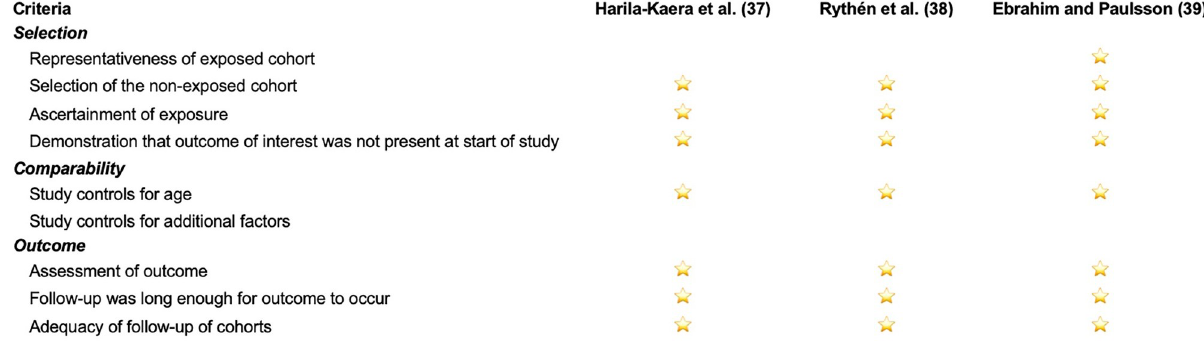
Fig 2. The Newcastle-Ottawa